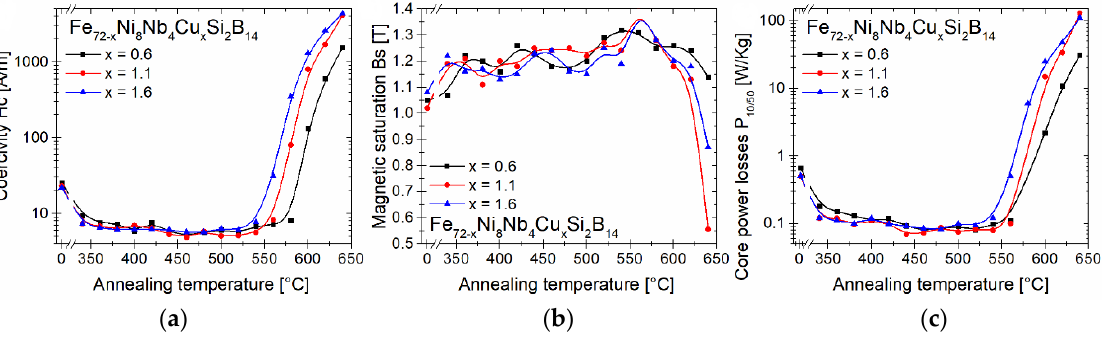
Figure 3. The DSC thermograms for heating rates ( a , c , e ) ranged from 10 to 100 °C/min and Kissin- ger plots determined for crystallization peak temperatures T x1 ( b , d , f ) of as-spun amorphous alloys.